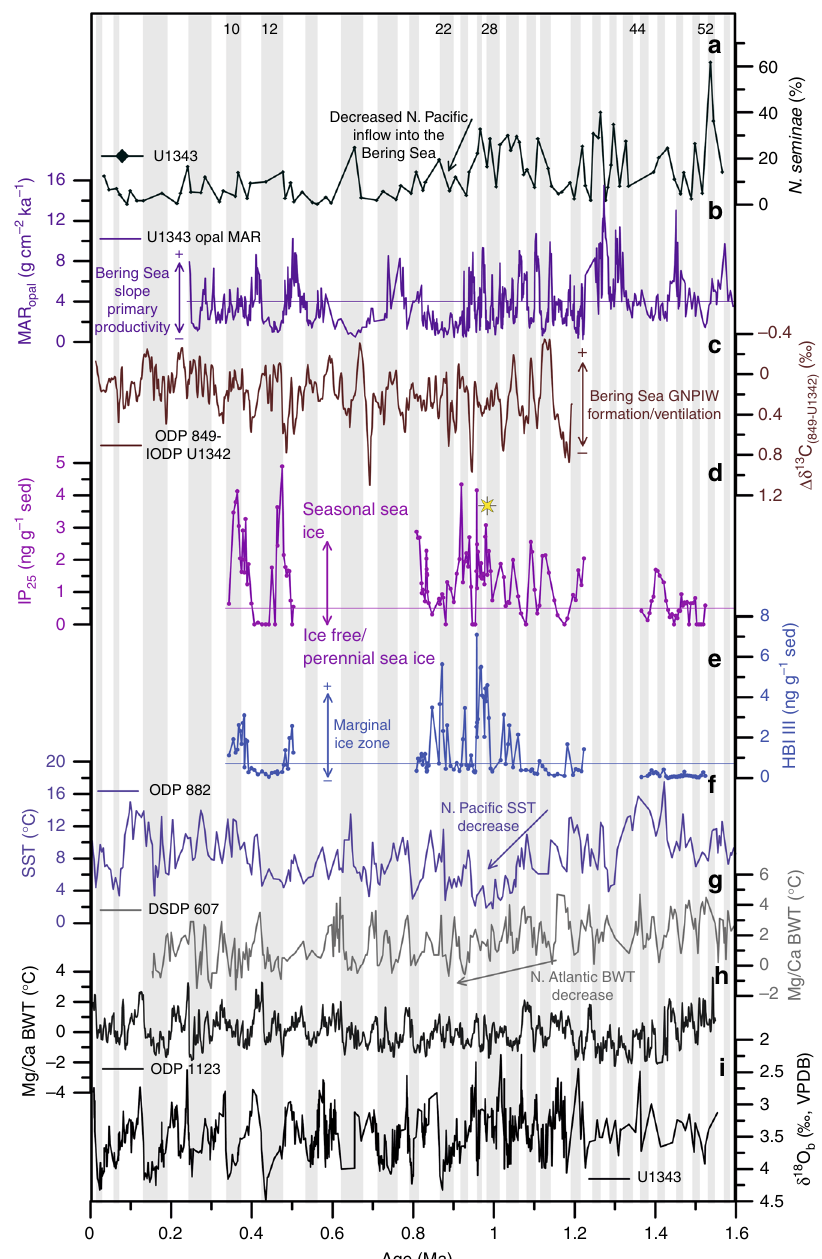
Fig. 4 Sea ice dynamics in the Bering Sea in comparison with regional and global climate records. Regional and global climate records across the Pleistocene. a Abundance of N. seminae in sediments of Site U1343 40 (dark green). b Site U1343 sedimentary MAR opal 36 (purple). c Δδ 13 C (849-U1342) 10 indicative of GNPIW ventilation/formation (brown). d Site U1343 IP 25 (violet) record (this study). The IP 25 peak labelled with an asterisk denotes the fi rst glacial interval (MIS 28) characterised by a late-glacial/deglacial sea ice maximum. e Site U1343 HBI III (blue) record (this study). f Alkenone-based North Paci fi c SSTs from ODP Site 882 51 (light purple). g BWT from DSDP Site 607 48 in the North Atlantic (light grey). h BWT from ODP Site 1123 50 in the southwest Paci fi c (dark grey). i Site U1343 δ 18 O b record (black) 42 . Grey bars indicate glacial intervals, white bars represent interglacials (numbers at the top correspond to MIS, MIS boundaries from Lisiecki and Raymo 16 ). The horizontal lines represent the boundaries for MAR opal , IP 25 and HBI III used to de fi ne sea ice